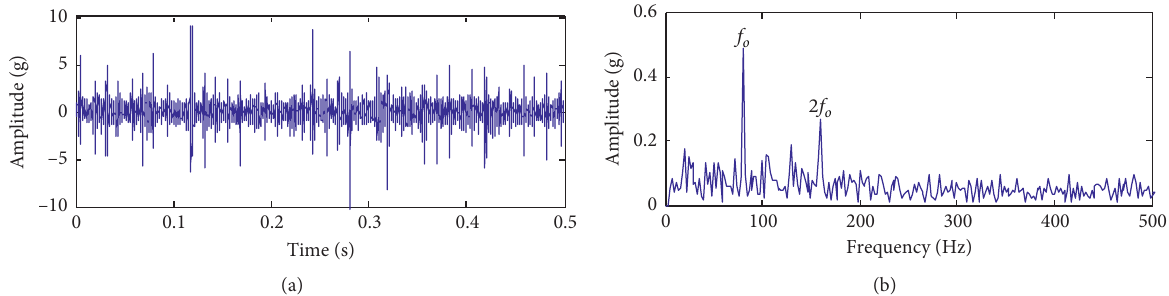
Figure 24: Comparison results of engineering signal by the MED method: (a) the waveform of deconvolution signal; (b) the envelope spectrum of deconvolution signal.